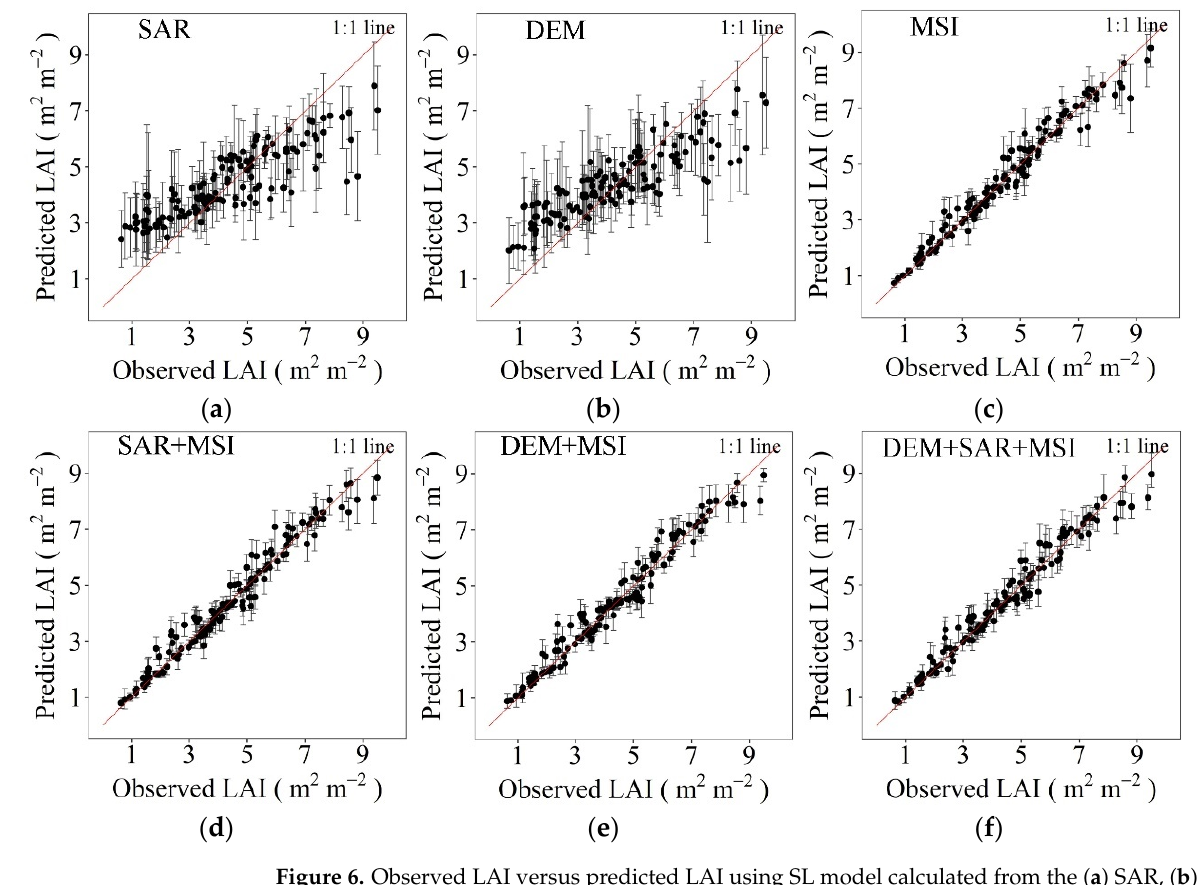
Figure 6. Observed LAI versus predicted LAI using SL model calculated from the ( a ) SAR, ( b ) DEM, ( c ) MSI, ( d ) SAR + MSI, ( e ) DEM + MSI and ( f ) DEM + SAR + MSI data in Gandong. Table 5. The accuracies of accuracy comparison of the different machine learning models in Xingguo and Gandong.